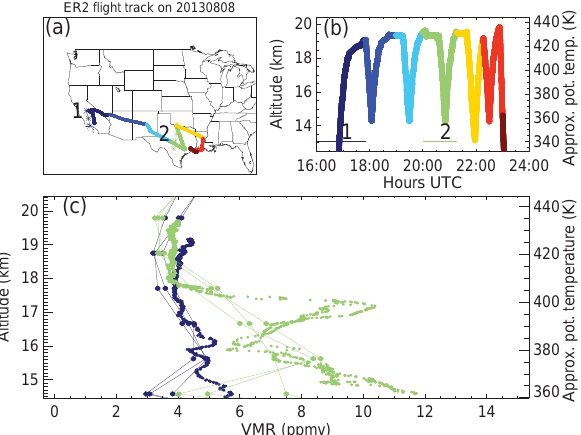
Figure 5. Map and profiles of aircraft and satellite water vapor on 8 August 2013 over California (number 1; shown in dark blue) and Texas (number 2; shown in green). (a) Map of the ER-2 aircraft flight track (solid colored trace) and nearly coincident Aura MLS geolocations (asterisks and lines). (b) ER-2 aircraft altitude profiles (solid colored trace) color coded by dives and MLS times (horizon- tal lines). (c) Vertical profiles of in situ water vapor measurements from JLH Mark2 (dots) and MLS retrievals of water vapor (circles and lines). Some measurements exceed the threshold for enhanced water vapor of 8ppmv for Aura MLS (after Schwartz et al., 2013) and the campaign-wide mean plus 2 standard deviations for JLH Mark2, 9.7ppmv at 380–400K and 6.6ppmv at